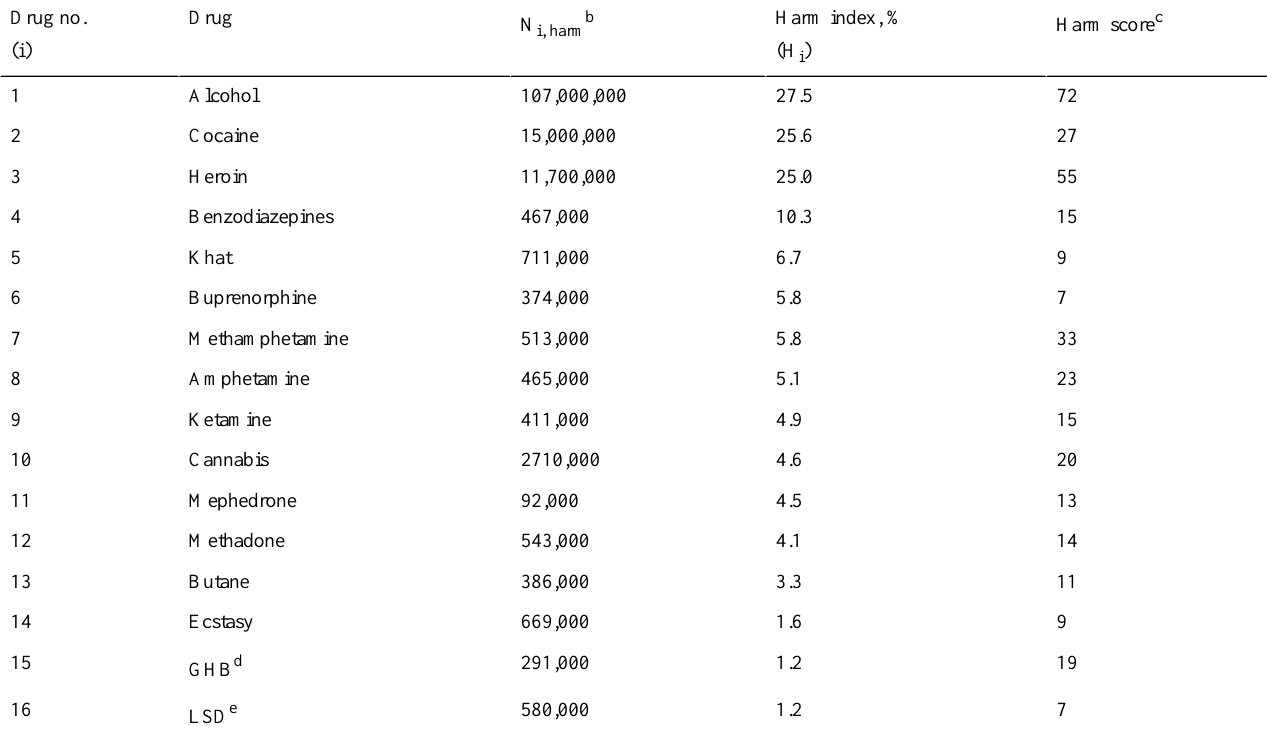
Table 3. Harmfulness of drugs as assessed by harm index (H i ) a (data acquired from Google search on June 20, 2014) and their harm